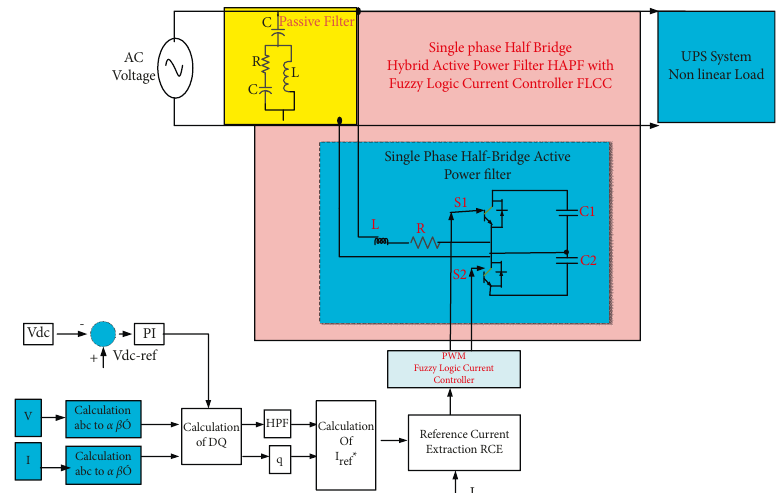
Figure 16: Power Supply Circuit for VSI and single-phase half-bridge HAPF with FLCC.